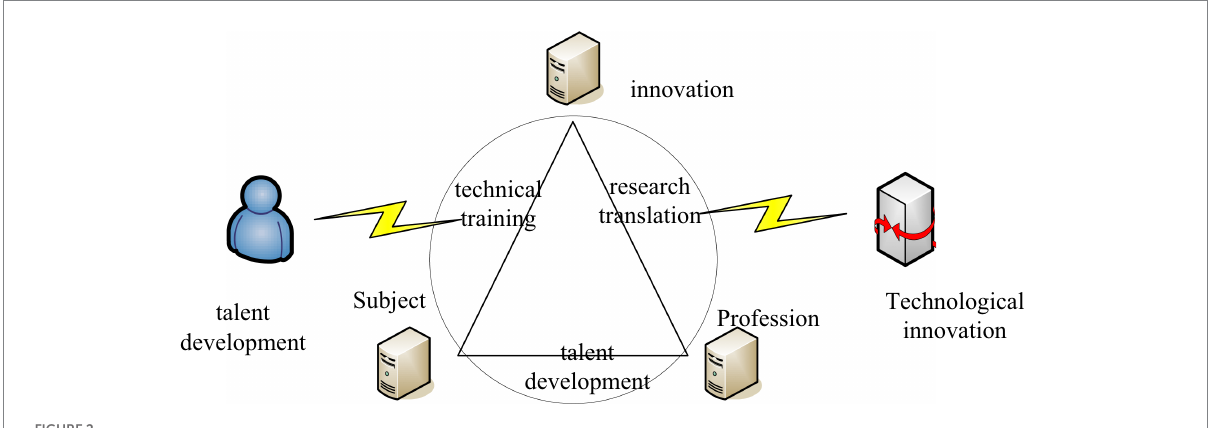
FIGURE 2 Contents related to the cultivation of modern talents.